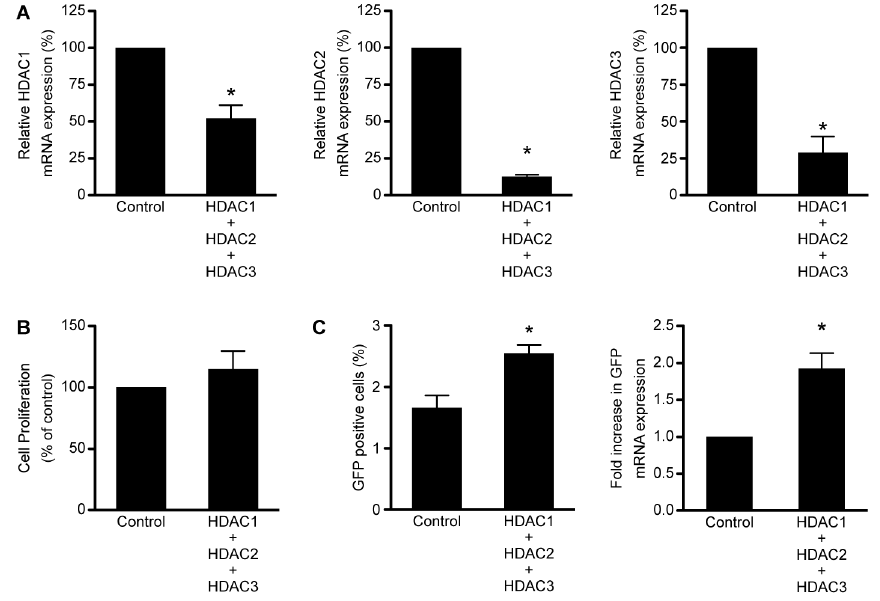
Figure 3. Depletion of HDAC1, 2 2, and 2 3 significantly increases expression from the HIV-1 promoter. A. Fold change of HDAC1, 2 2, and 2 3 mRNA expression as compared to 2D10 cells transduced with the scrambled shRNA control. A significant reduction in the mRNA expression of all three HDACs was observed. B. Cell viability and proliferation as a percentage of the 2D10 cells transduced with the scrambled shRNA control. Depletion of HDAC1, 2 2, and 2 3 did not significantly affect cell viability and proliferation. C. A significant increase in the percentage of cells expressing GFP protein from the HIV-1 promoter was observed following depletion of HDAC1, 2 2, and 2 3. Furthermore, a significant increase in expression of GFP mRNA from the HIV-1 promoter was observed following depletion of HDAC1, 2 2, and 2 3. (*p , 0.05).